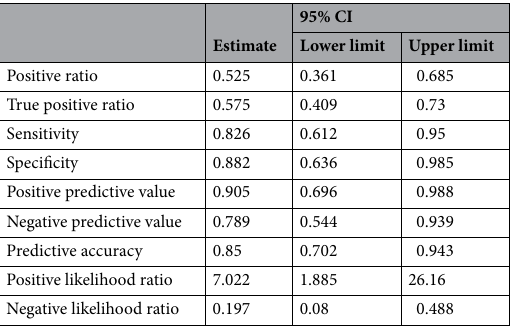
Table 6. Predictive accuracy measures. CI : confidence